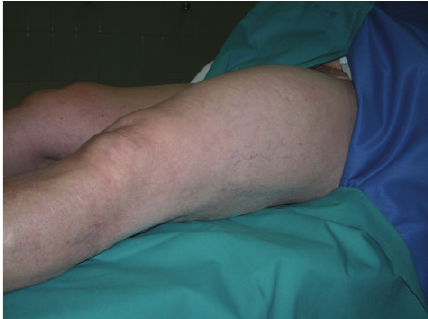
Figure 1: Enlargement of the left thigh.